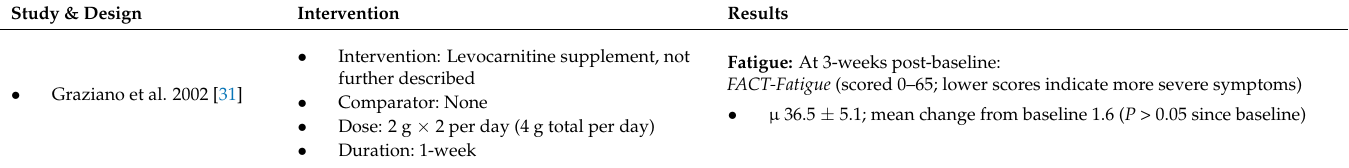
Table 2. Intervention and Results of Included